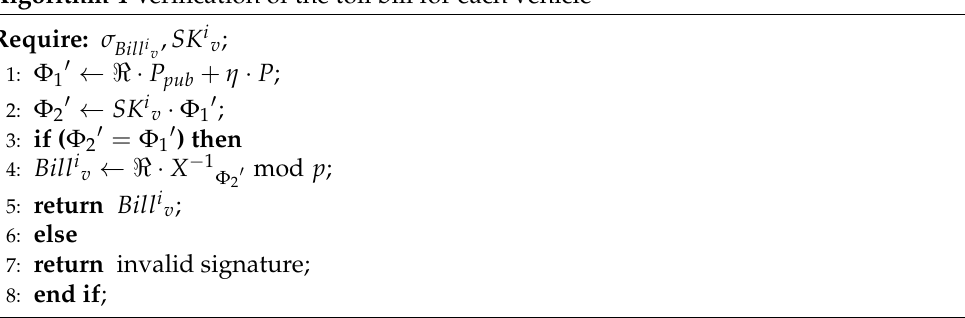
Algorithm 4 Verification of the toll bill for each